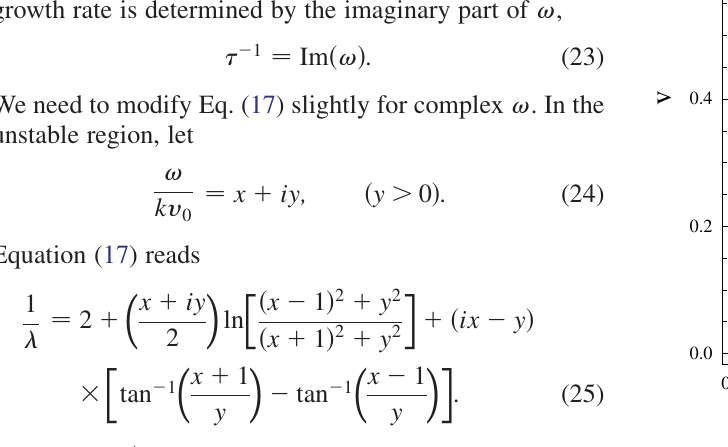
FIG. 3. (Color) v vs u according to Eq.